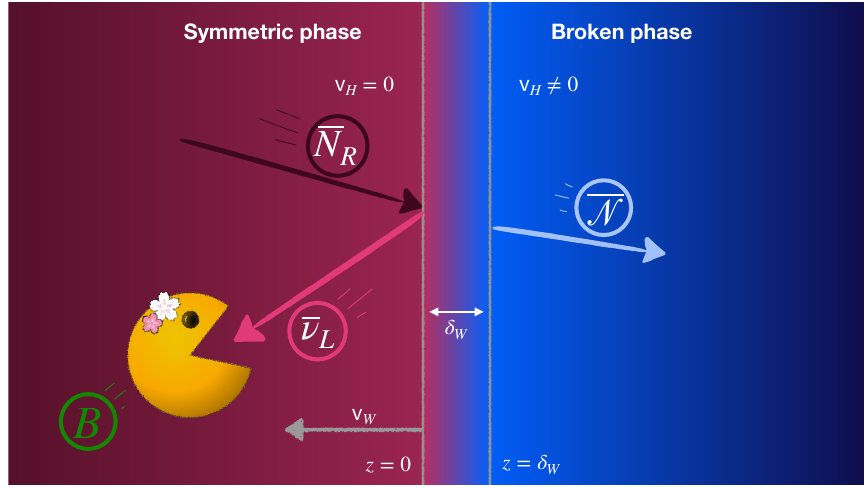
Figure 1 . Sketch of the re(cid:13)ection of (cid:22) N R o(cid:11) a bubble whose wall width is (cid:14) W to (cid:22) (cid:23) L and its subsequent conversion to baryons through shpaleron processes. If there is CP violation, the re(cid:13)ected (cid:23) L